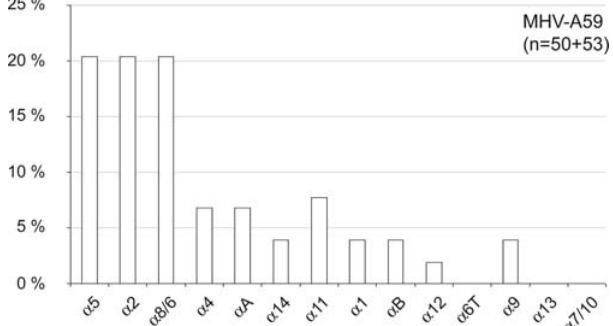
Figure 1. Relative expression of the various IFN- a subtypes in MHV-A59 infected livers. IFN- a coding sequences were amplified by RT-PCR using a primer mixture designed to amplify equally the different murine IFN- a subtypes [33]. PCR products were then cloned and individual clones were sequenced. The histogram shows the percent- age of sequences from 2 mice (50 and 53 sequences) corresponding to each IFN- a subtype.